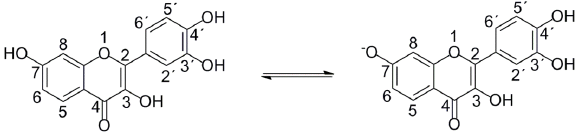
Figure 6: Fisetin protonated and deprotonated species. Fisetin pK of OH group at C7 position is 7.27 in water environment. Various eye drops differ in pH values resulting in the different ratio between protonated and deprotonated fisetin